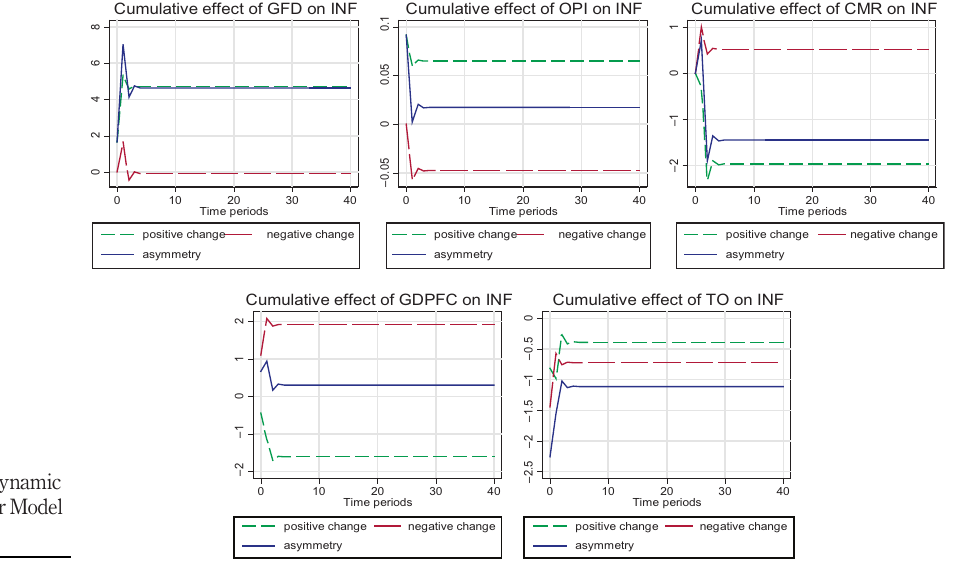
Figure 4. Cumulative dynamic multipliers for